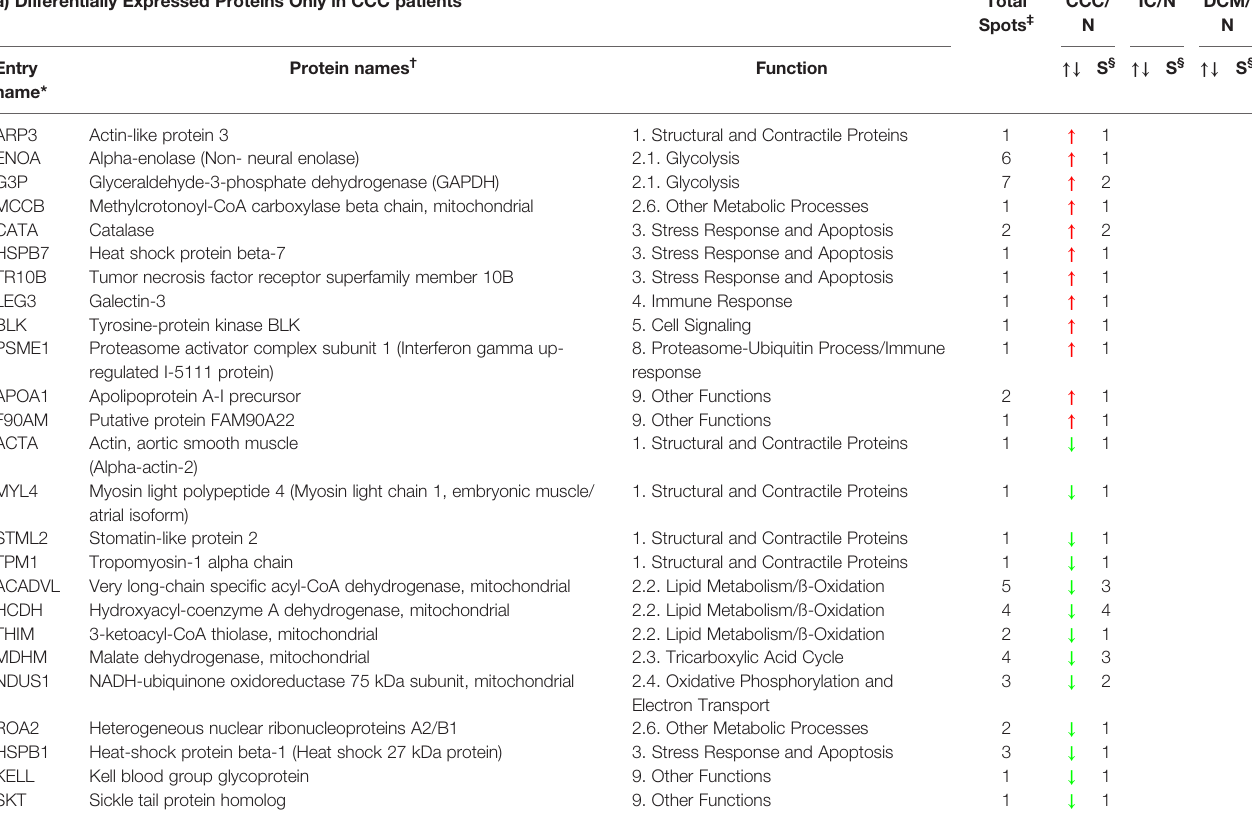
TABLE 4 | List of the differentially expressed proteins identi fi ed in the myocardium from patients with CCC, IC and DCM when compared to individuals without cardiomyopathies. a) Differentially Expressed Proteins Only in CCC